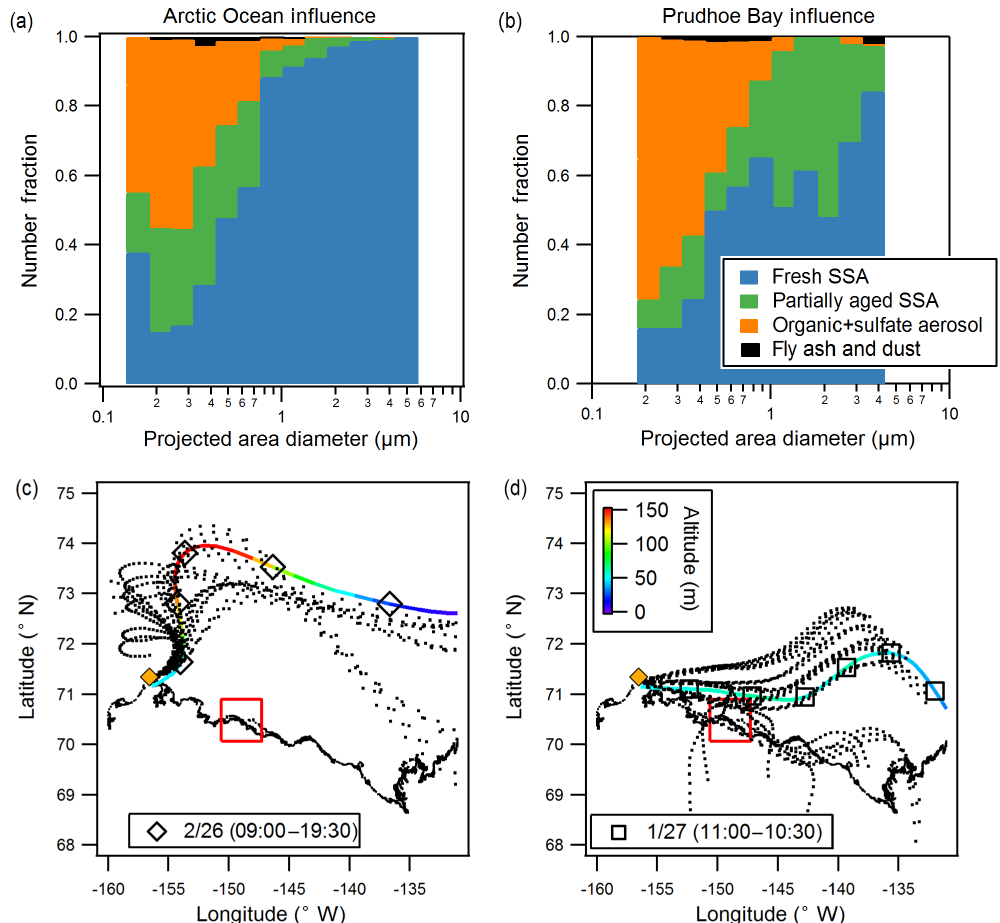
Figure 5. Size-resolved number fractions of observed particle types (CCSEM-EDX), for example sample periods influenced by (a) the Arctic Ocean (26 February day, 4490 particles) and (b) Prudhoe Bay (27 January, 1475 particles). Air mass influence is shown for (c) 26 February daytime and (d) 27 January as determined by NOAA HYSPLIT 48h backward air mass trajectories. Both ensemble (dotted line) and single representative trajectories are shown. Color scale indicates air mass altitude, and markers are placed at 6h intervals. Red line shows extent of Prudhoe Bay emissions influence box (Kolesar et al., 2017). Yellow diamond indicates sampling site near